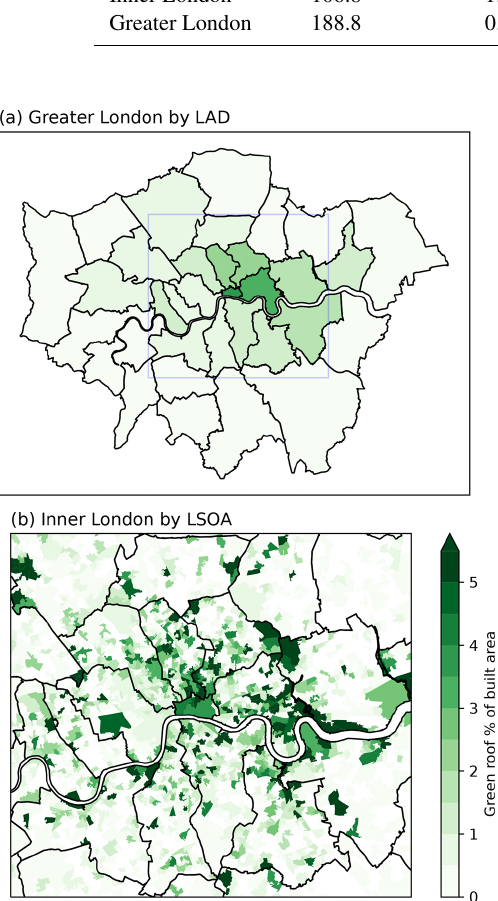
Figure 7. Area of green roof identified in (a) LADs and (b) LSOAs as a fraction of total building footprint